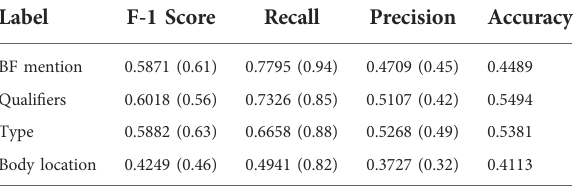
TABLE 4 Token-based body function evaluation test sample (results from prior work are in